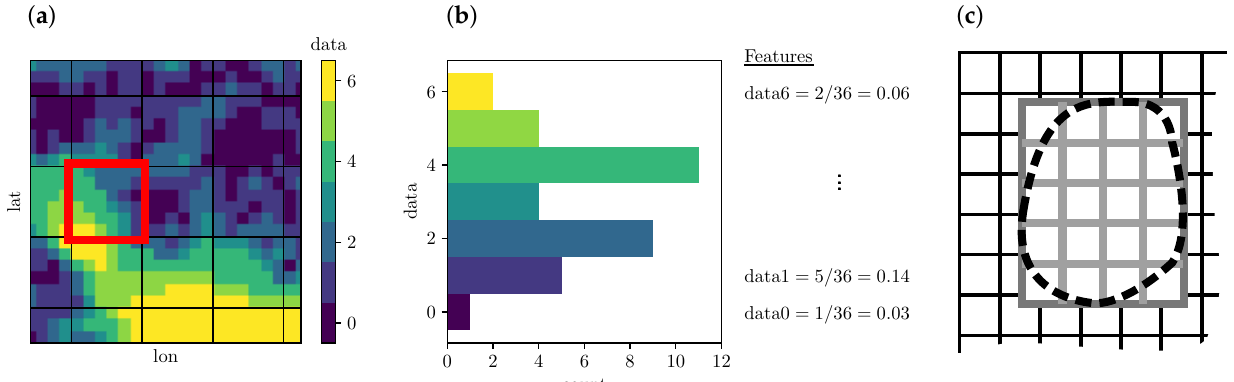
s . ( b ) Within each tile, we compute the ×